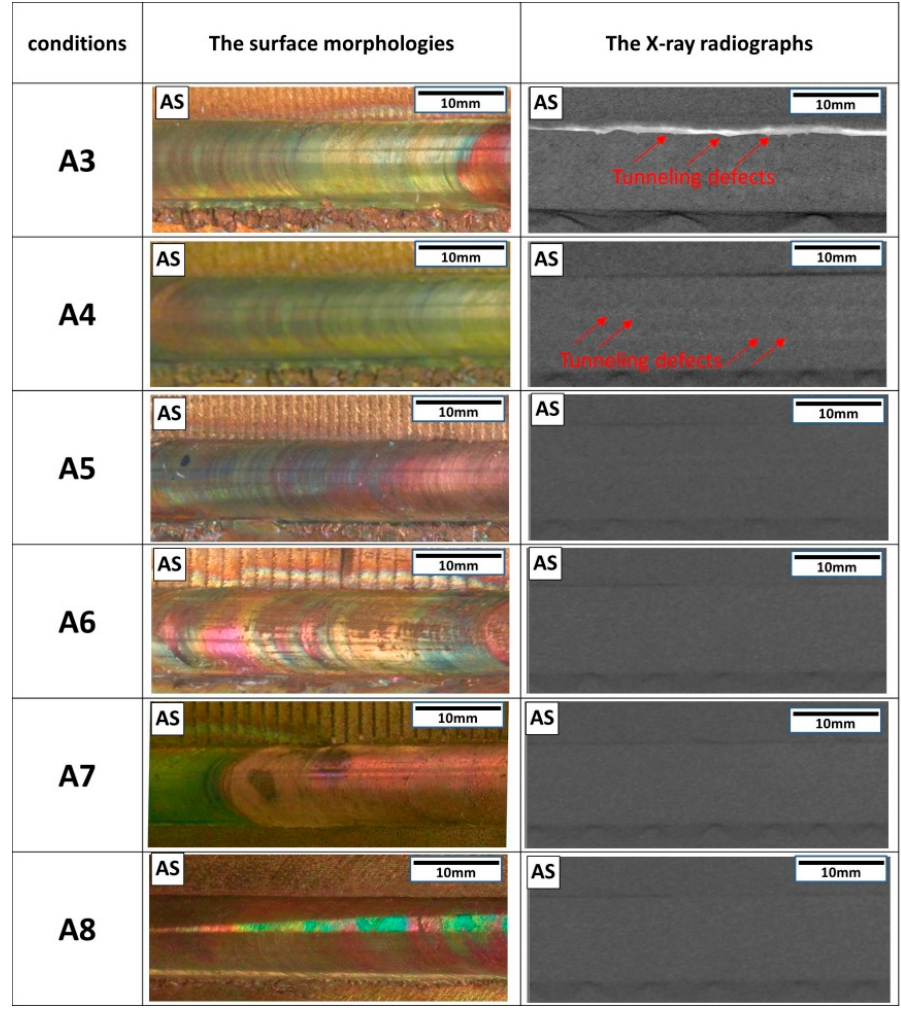
Figure 3. The surface morphologies and the relevant X-ray radiographs of welded joints under conditions A3–A8.